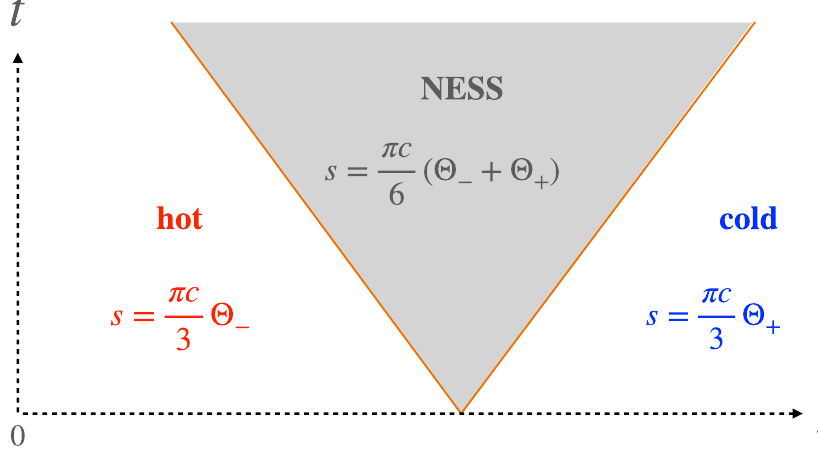
Figure 1 . When two identical semi-infinite quantum wires at temperatures Θ ± are joined at t = 0 , a NESS forms inside an interval that expands at constant speed in both directions [5]. The entropy density s ( t, x ) is shown in the three regions of the protocol. The energy density profile is identical, except for the replacement Θ Θ 2 1 ± → ± 2